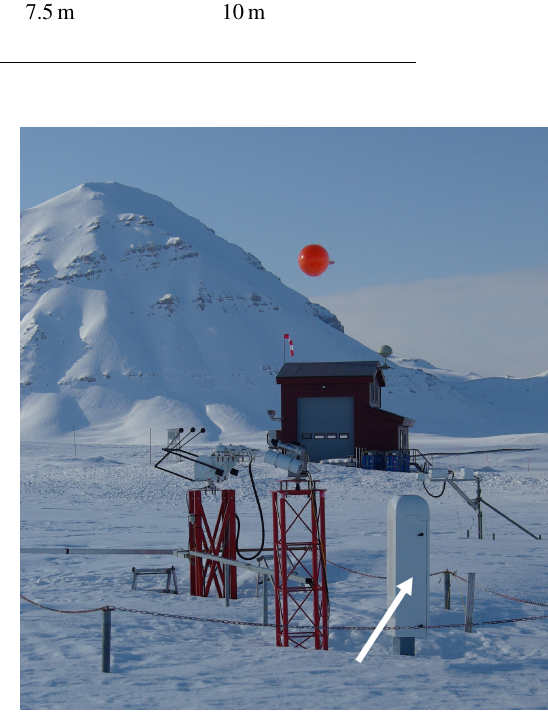
Figure 1. The CL-51 ceilometer (indicated by a white arrow) lo- cated in the vicinity of the radiation measurements of the AWIPEV station at Ny-Ålesund, in April 2013. In the background the balloon facility for radiosonde launches, and a red tethered balloon (photo: Jürgen